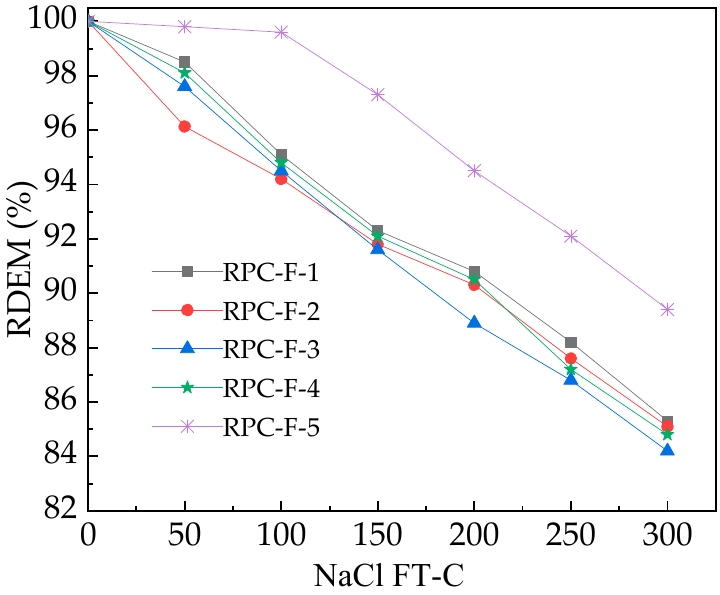
Figure 5. The RDEM of RPC during NaCl FT-C.